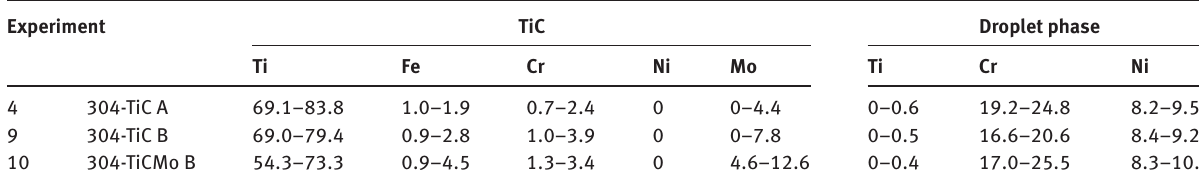
Table 6: Average analysis of TiC particles and the alloy on the droplet side of experiments with stainless steel 304 (in mass%)